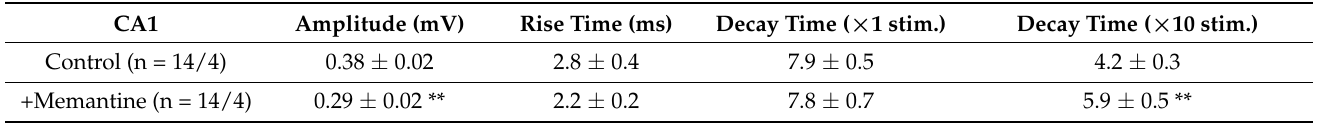
Table 1. Amplitudes and kinetics of fEPSPs in the CA1 area of hippocampus. Are shown the decay time after one ( × 1 stim.) or ten ( × 10 stim.) stimuli. Asterisks indicate statistically significant differences (** p < 0.01; n are numbers of tested areas and animals (areas/animals)). CA1 Amplitude (mV) Rise Time (ms) Decay Time ( × 1 stim.) Decay Time ( × 10